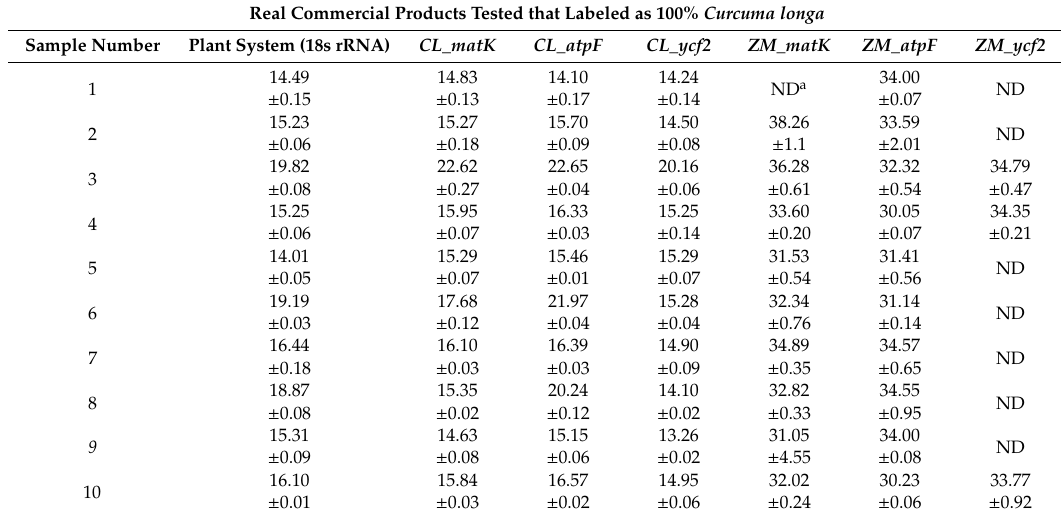
Table 4. Result of the real-time PCR assay using 10 commercial products.